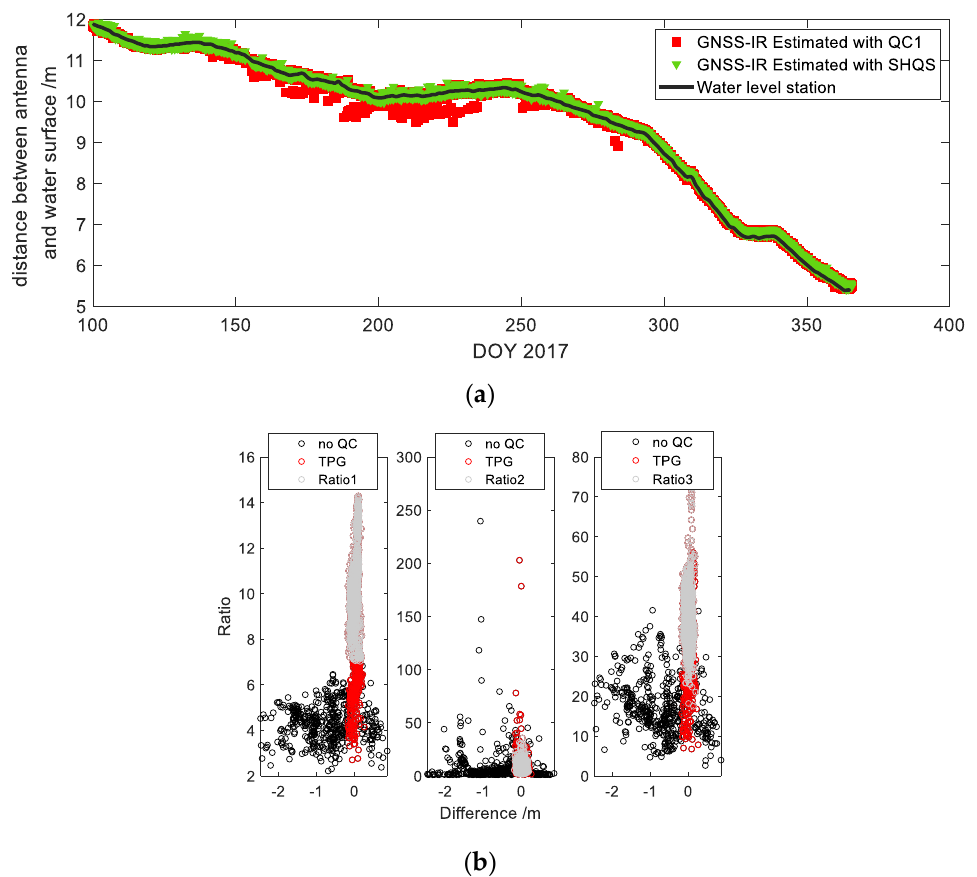
Figure 10 . ( a ) Comparison of different quality control methods for water level inversion at Shuangwangcheng Reservoir. QC1 refers to the threshold setting method of Ratio1. The solid black line represents the records of water level station. ( b )The results of the water level at a station on the reservoir dam with different methods of quality control.